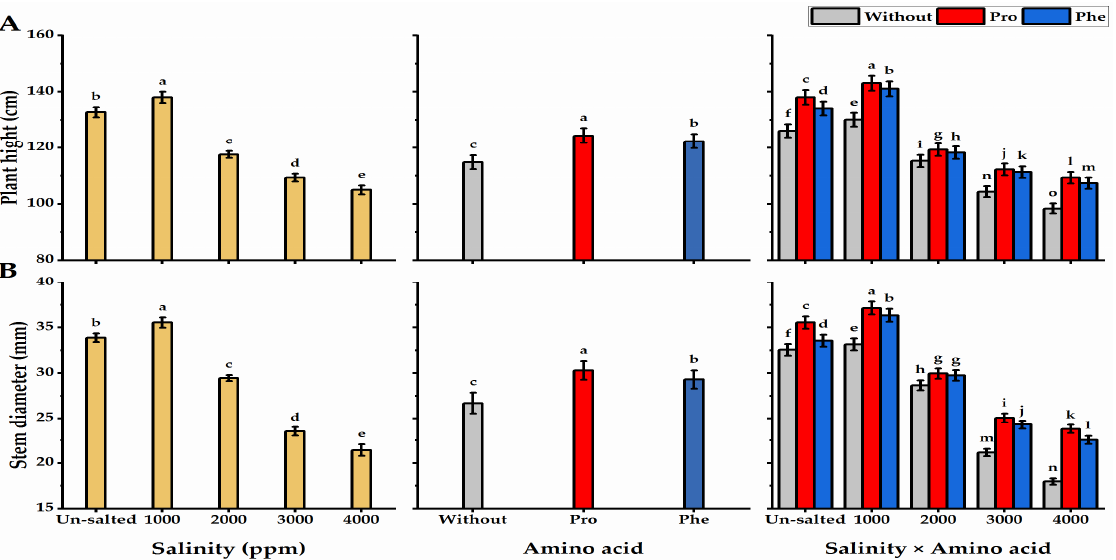
Figure 1. Influence of exogenous spray treatments of proline (Pro) or phenylalanine (Phe) on ( A ) plant height and ( B ) stem diameter of moringa trees cultivated under different levels of salinity. Data are mean value ± SE. Bars with different letters are significantly different at p ≤ 0.05 level.